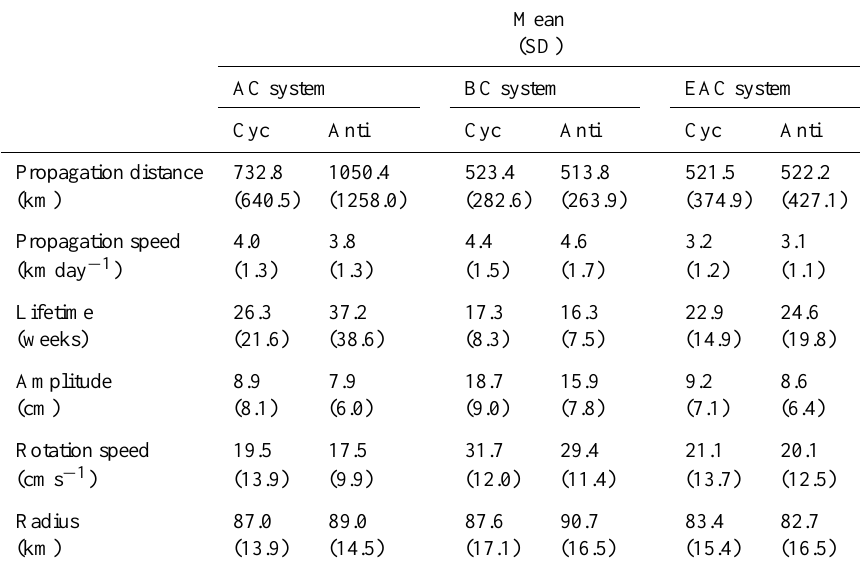
Figure 8. Eddy mean propagation speeds (colours) and directions (arrows) for 1 ◦ × 1 ◦ cells containing more than 20 eddies in the (a) AC, (b) BC, and (c) EAC systems. Table 1. Mean (and SD) properties and characteristics of cyclonic (Cyc) and anticyclonic (Anti) long-lived eddies. See text for description of mean